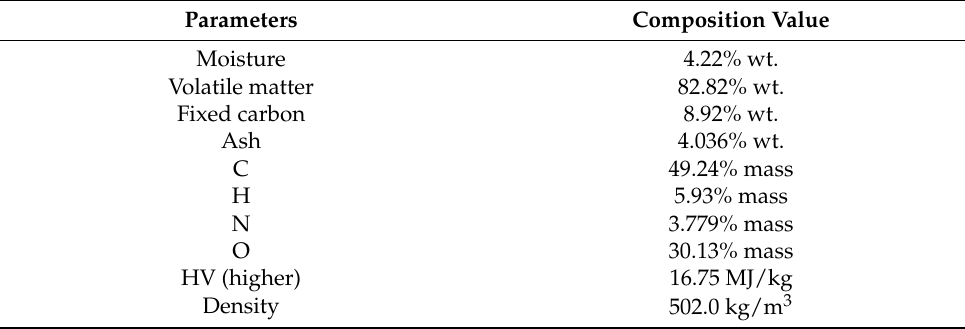
Table 2. Redgram stalk biomass composition